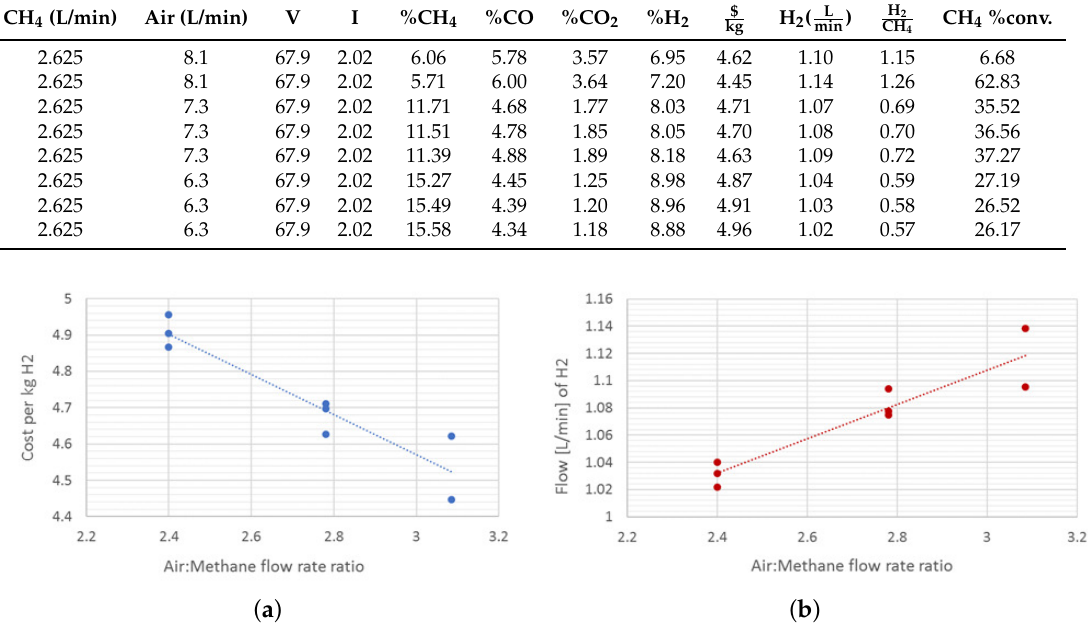
Figure 6. ( a ) Variance of cost per kg of generated H 2 ; and ( b ) variance of Flow rate of generated H 2 with Air:Methane